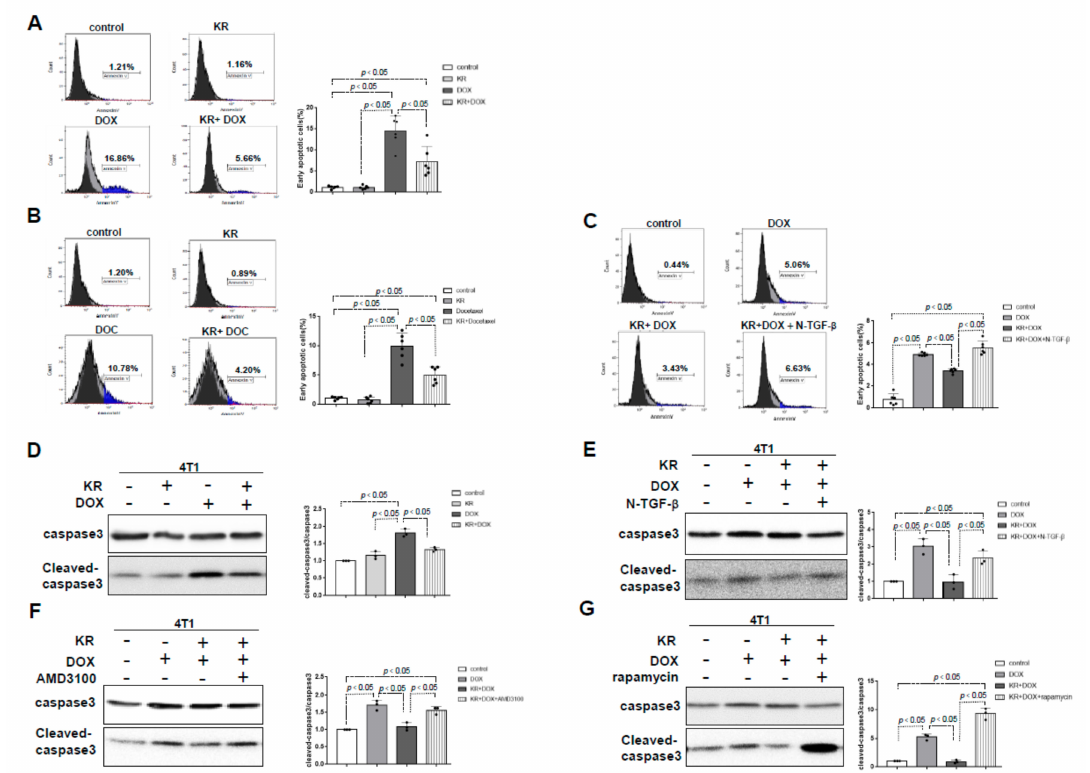
Figure 4. DPP-4 inhibition protects breast cancer cells from apoptosis. ( A – C ) Detection of